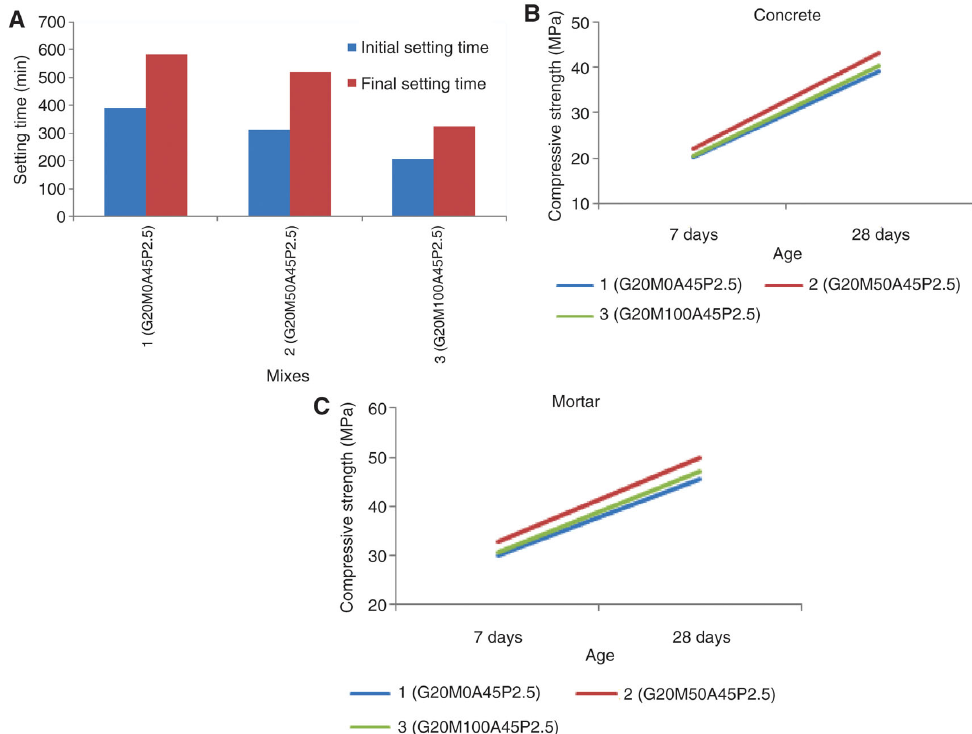
Figure 5: Effect of manufactured sand on the setting time (A), compressive strength of geopolymer concrete and mortar (B) and